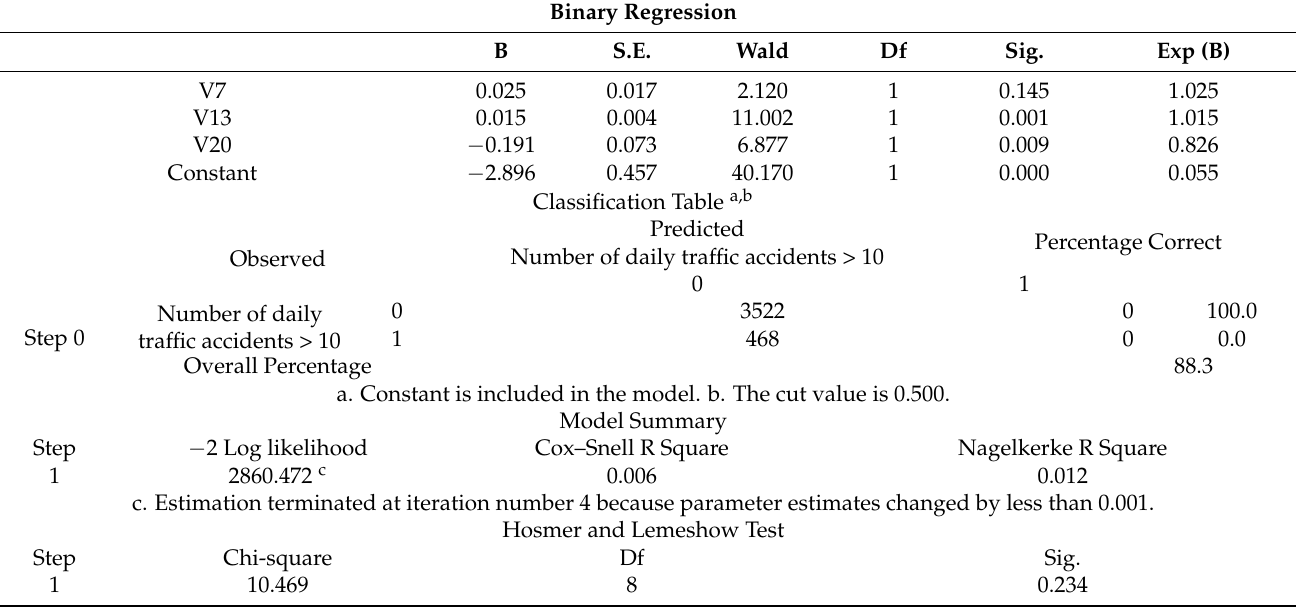
Table 10. Results of applied logic regression with the selected subset of 3